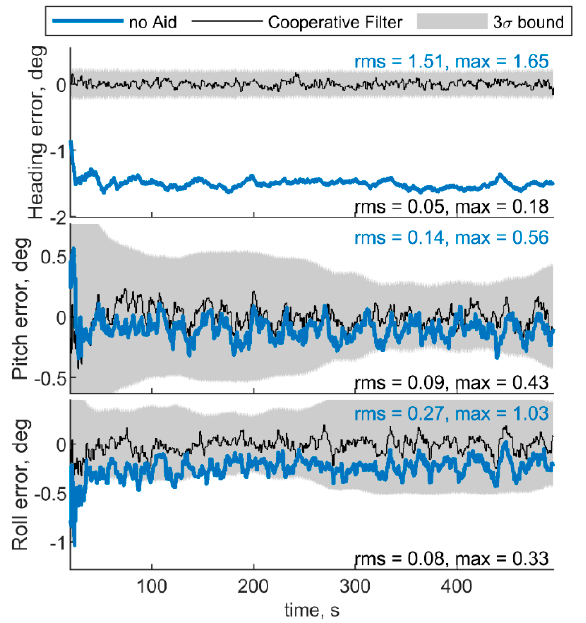
Figure 15. Errors on angle estimated by the cooperative filter in blue and by the same filter without using cooperation. One deputy. Chief and deputy move along UAV 1 and UAV 2 trajectories reported in Figure 13, respectively.